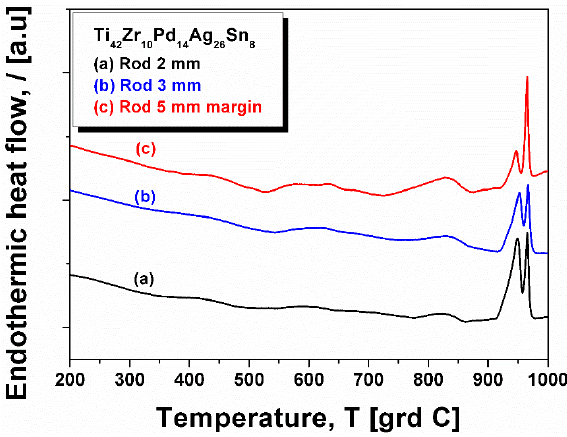
Figure 7. DSC thermograms of rods with 2 mm and 3 mm diameter. For comparison, the thermogram stemming from the margins of 5 mm diameter rod is also presented. ( a ) sample taken from rod with 2 mm diameter; ( b ) sample taken from rod with 3 mm diameter; ( c ) sample taken from a margin of a 5 mm diameter rod.